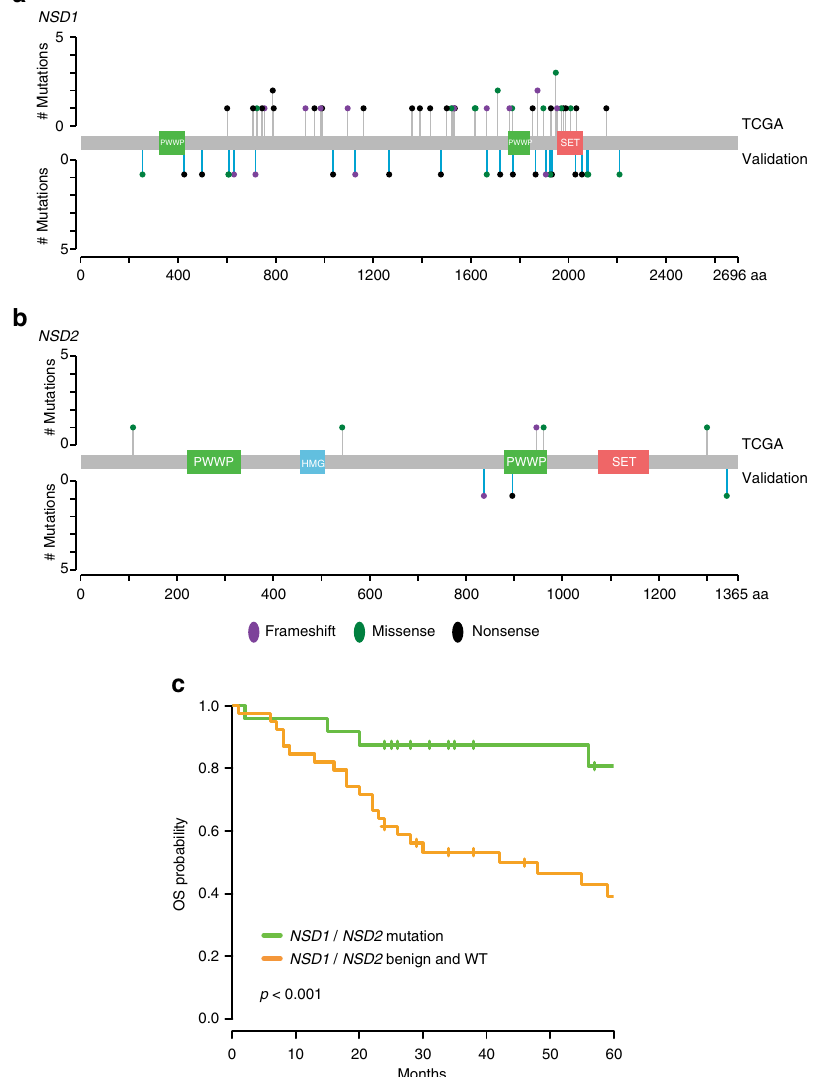
Fig. 4 Validation of NSD1 and NSD2 mutations in an independent laryngeal cancer cohort. a Plot indicates the location of nonsense (black), frameshift (purple), and missense (green) mutations affecting the NSD1 protein. NSD1 functional domains are indicated. Lollipops above the line indicate mutations reported in the TCGA. Lollipops below the line depict mutations identi fi ed in the validation cohort. b Plot similar to a , for NSD2. c Kaplan – Meier curve indicates OS of patients with laryngeal tumors with damaging NSD1 or NSD 2 mutation ( n = 24) or without such mutations ( n = 39), in the validation cohort ( p -value from log-rank